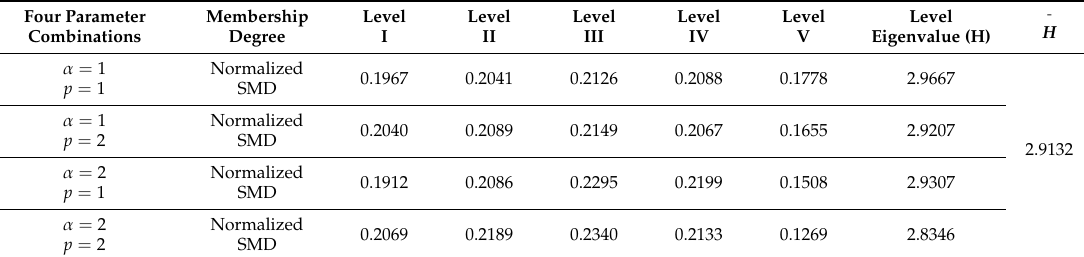
Table 6. Results of SMD and level eigenvalues of a social impact assessment for a dam break.